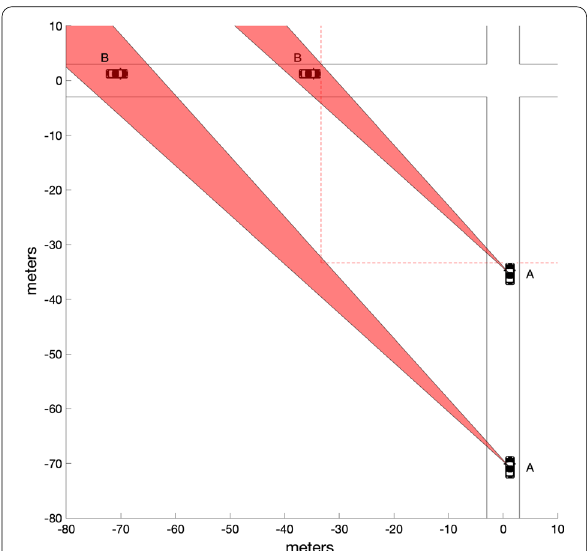
Fig. 5 Illustration of how car B may remain trapped in the A-pillar blind zone (red region) of car A until after they have passed a conservative estimate (reaction time 1.5 s., dry road) of the stopping distance for cars riding at 50 km/h (red dotted lines). The cars are shown at two different points of time. In this example, equal speeds are assumed. The A-pillar bearing is 45° and the A-pillar obstruction angle is 7.3°, which are realistic average values (see text). Note that the A-pillars of some vehicles have considerably larger obscuration angles, and that the obscuration angle may increase even further if the driver is sitting closer than the most rearward position of the seat. The cars are 4 m long and 1.75 m wide, which corresponds to the measures of a typical four-person car (e.g. VW Polo)